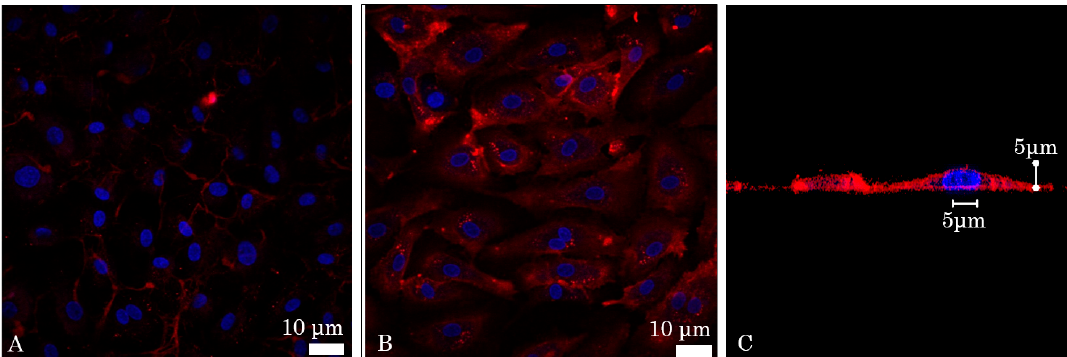
Figure 1. Florescent confocal images of in vitro affinity of the intercellular adhesion molecule-1 (ICAM-1) antibody: ( A ) Inactivated and ( B ) Tumor Necrosis Factor Alpha (TNF- α ) activated Human Umbilical Vein Cells (HUVEC). The nuclei (blue) were stained with DAPI (4 ′ ,6-Diamidino-2-Phenylindole, Dilactate) ( C ) deconvolved image of a cell. The fluorescence signal (red) is not present in the cytoplasm or the nucleus, but is, rather, located on the cell membrane.